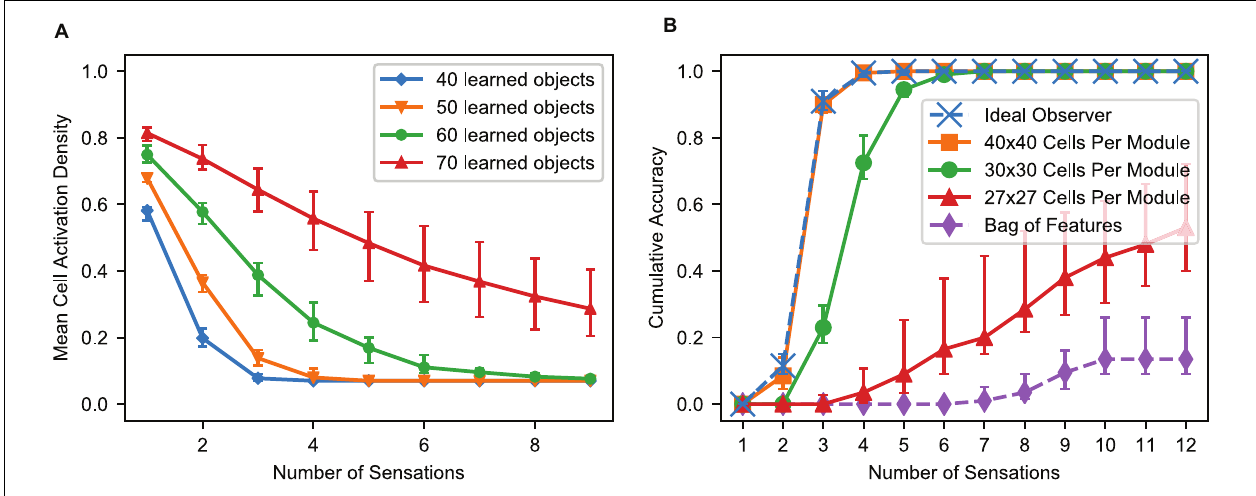
FIGURE 7 | (A) With multiple sensations, the location layer activity converges to a sparse representation. Using the same simulation from Figure 6 , we show the activation density after each sensation, averaged across all objects and modules. With additional sensations, the representation becomes sparser until the object is unambiguously recognized. With more learned objects, the network takes longer to disambiguate. The activation density of the first sensation increases with the number of learned objects. If the initial activation density is low, the network converges very quickly. If it is high, convergence can take longer. (B) Comparison of this network’s performance with the ideal observer and a bag-of-features detector. Each model learned 100 objects from a unique feature pool of size 10. We show the percentage of objects that have been uniquely identified after each sensation, averaged across all objects for 10 separate trials. The ideal model compares the sequence of input features and relative locations to all learned objects while the bag-of-features model ignores relative locations. With a sufficiently large number of cells per module, the proposed neural algorithm gets similar results to the ideal computational algorithm. (A,B) In both of these charts, we repeat the experiment with 10 different sets of random objects and we plot the 5th, 50th, and 95th percentiles for each data point across